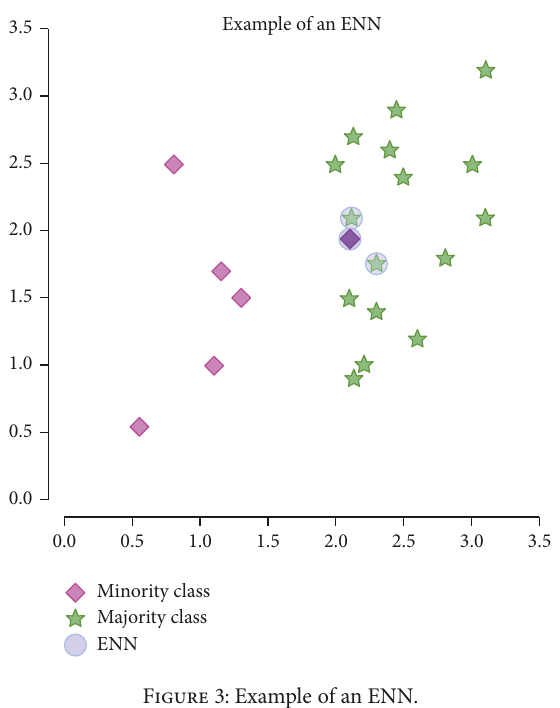
Figure 3: Example of an ENN.